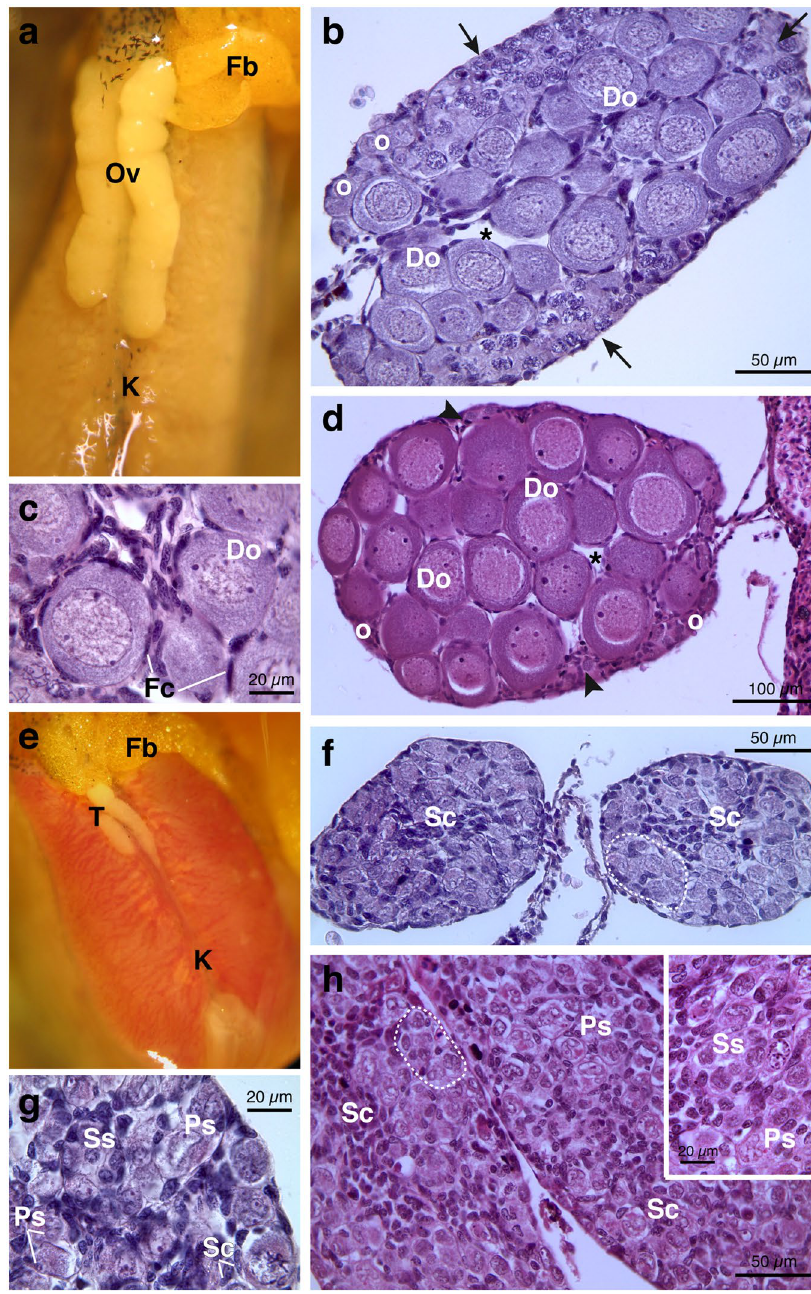
Figure 1. Representative photomicrographs and histological sections of ovaries and testes from Hyla intermedia juveniles under basal condition. ( a ) Ovaries and ( e ) testes in ventral view associated with the kidney; the fat bodies are present at the left side. ( b , c ) Cross-sections showing typical ovarian tissue of an ovary at stage VIII: the ovarian cavity is filled with growing diplotene oocytes; note in the cortex proliferating areas of oogonia and nests of leptotene-pachytene meiocytes (arrows). ( c ) Magnification of diplotene oocytes surrounded by follicular cells. ( d ) Cross-section of an ovary at stage IX filled by numerous and large growing diplotene oocytes; the proliferating germ cells are restricted at periphery (arrowheads). ( f ) Cross-section of testes showing proliferating spermatogonia into developing seminiferous tubules (marked by dotted lines); somatic cell are flattened and darkly stained. ( g ) At higher magnification it is possible to distinguish primary and secondary spermatogonia. ( h ) Longitudinal sections of testicular tissue showing developing seminiferous tubules. (Ov = ovaries; T = testes; K = kidney, Fb = fat body; Do = diplotene oocytes; Fc = follicular cells; o = oogonia; * = ovarian cavity; Sc = somatic cells; Ps = primary spermatogonia; Ss = secondary spermatogonia). All sections are